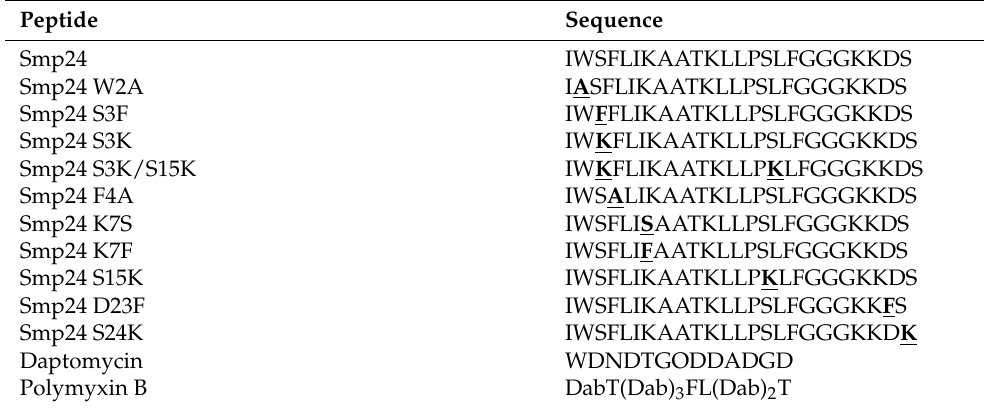
Table 1. Sequences of peptides used in this study. Amino acids that differ from the Smp24 peptide are in bold.